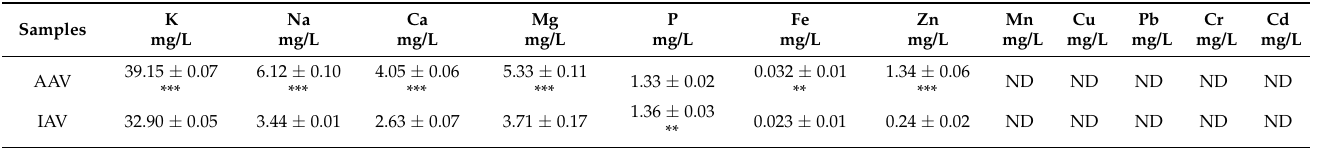
Table 2. Content of mineral elements of vinegar samples.